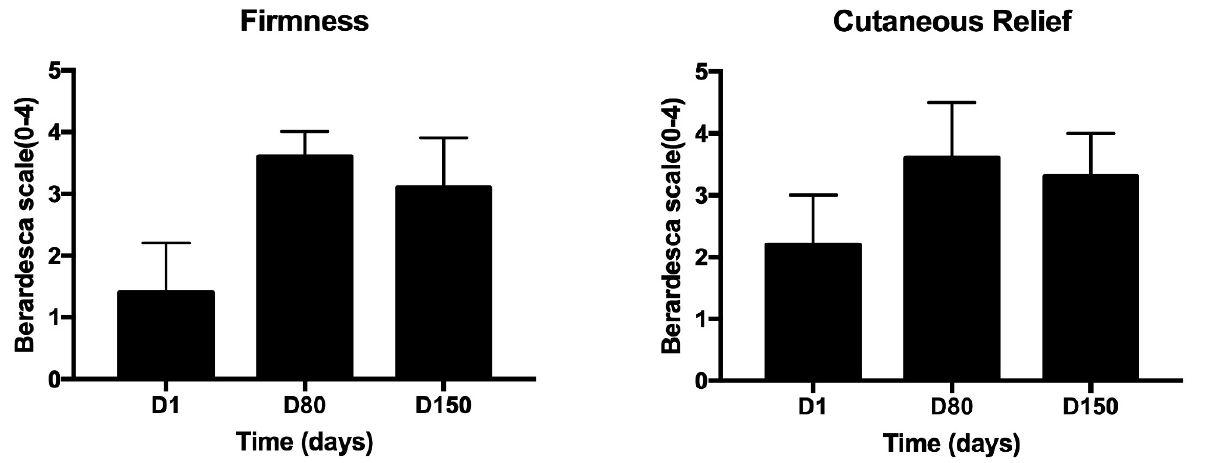
Figure 2. Berardesca Scale for the patient’s satisfaction evaluation. Subjects’ evaluation of their satisfaction in comparison to D0 (before treatment), after 1 day, 80 and 150 days, by giving scores on firmness and cutaneous relief. Scale of 0–4 for each criterion (0 = unsatisfactory; 4 satisfactory).